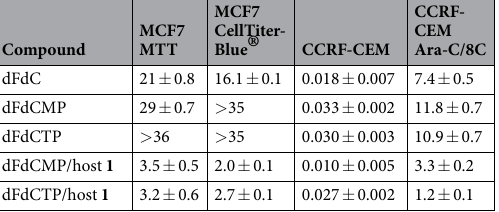
Table 2. In vitro cytotoxic activities (IC 50 * , µ M) on human cancer cell lines of free gemcitabine (dFdC) and its active phosphorylated forms (dFdCMP and dFdCTP) free or encapsulated in host 1 . * The value of IC 50 was calculated from the dose–response curve presented as dependence of cell viability on the concentration of studied